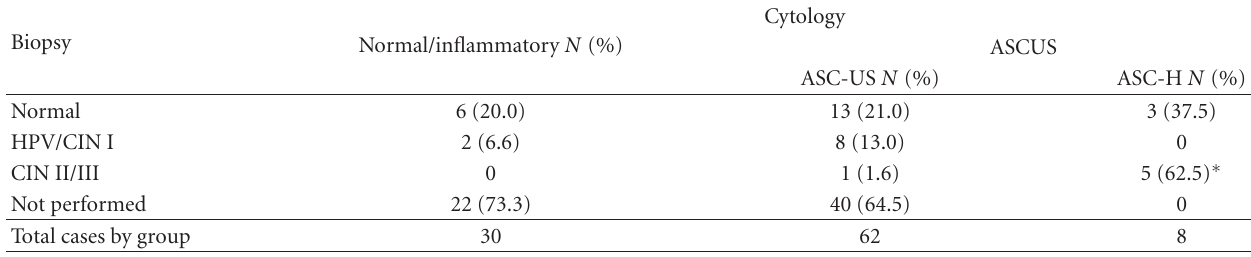
Table 4: Results of the biopsies performed on the total group of patients with an initial diagnosis of ASCUS who, after review, were reclassified as having cytologies that were normal/inflammatory, ASC-US, and ASC-H, which showed changes in the colposcopic